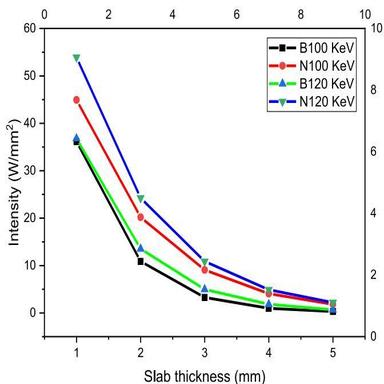
Measured x-ray transmitted intensities across slab of varying thicknesses.